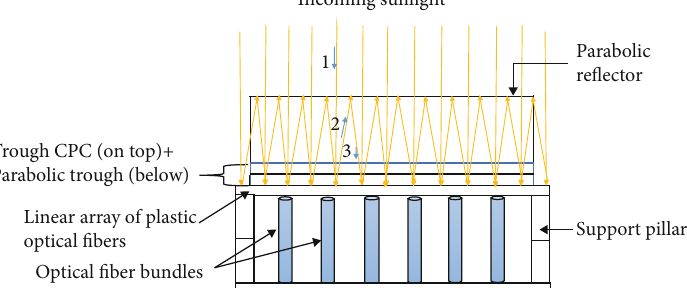
Figure 3: Front view of the physical layout of parabolic trough daylighting system by introducing the trough compound parabolic concentrator (CPC) before the optical fi bers (source: adapted from